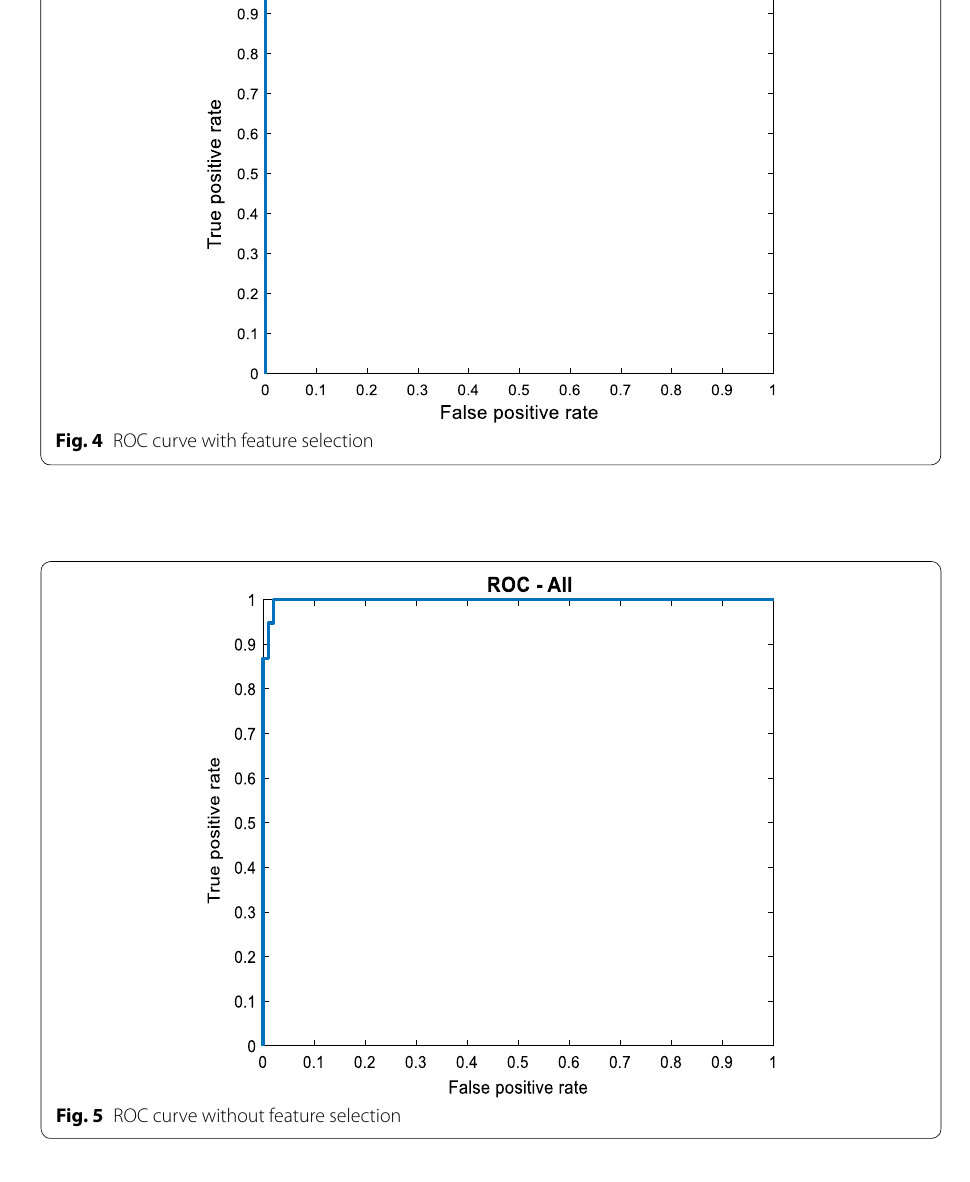
Table 5 Mean square error